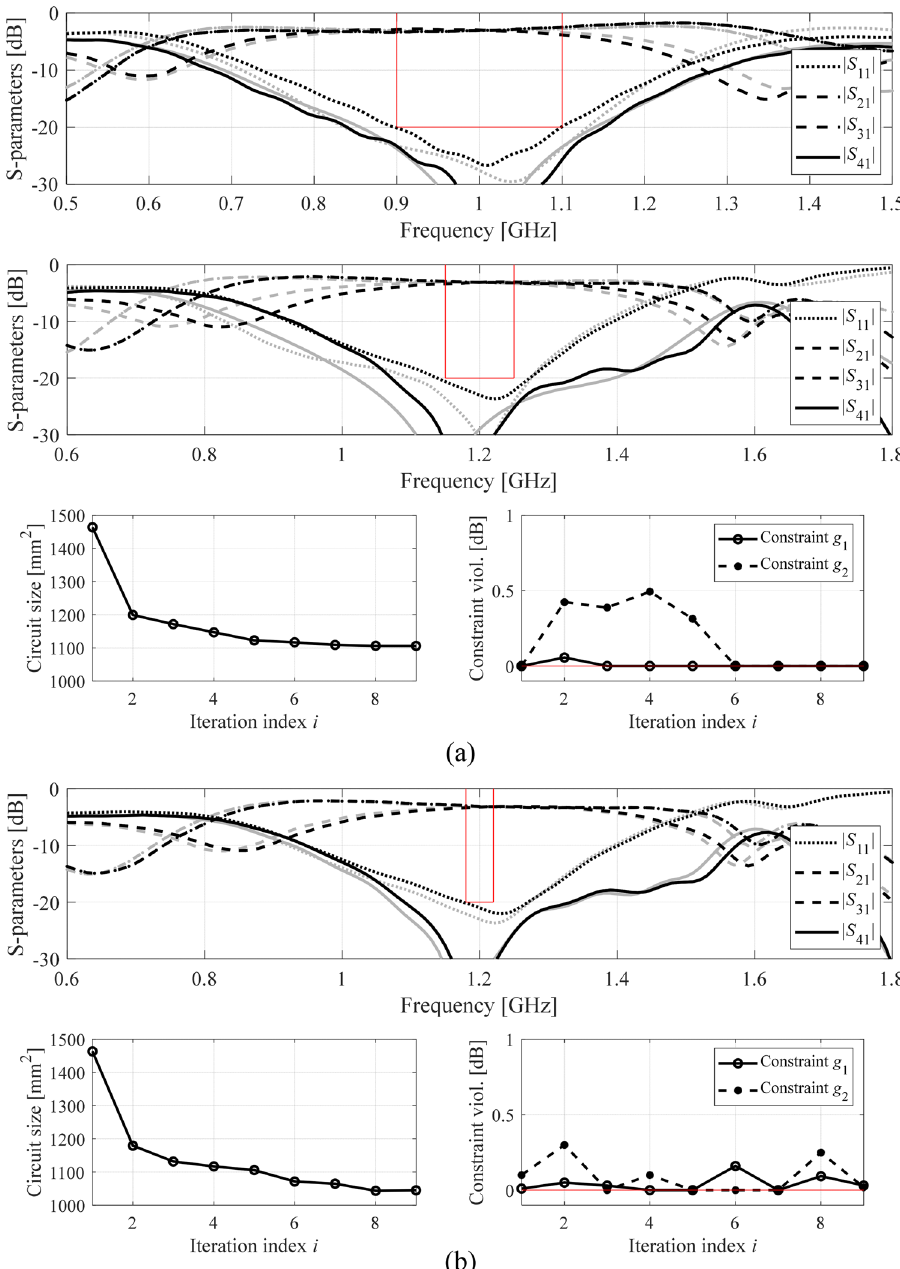
Figure 6. Initial (gray) and optimized (black) S -parameters of Circuit III. The vertical and horizontal lines mark the target operating bandwidth and the acceptance level for the matching | S 11 | and isolation | S 41 | responses. Also shown is the evolution of the circuit size and constraint violations (in case of feasibility, violations shown as zero): ( a ) design scenario I (bandwidth 1.15–1.25 GHz), ( b ) design scenario II (bandwidth 1.18–1.22